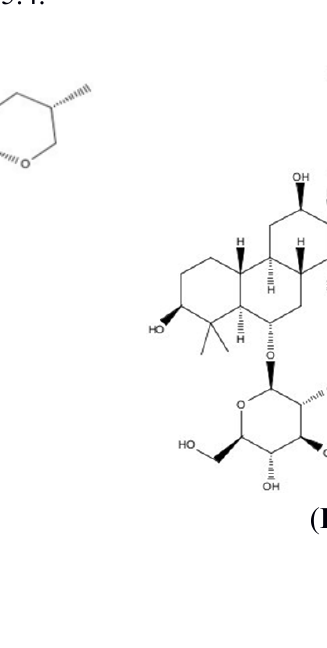
Figure 1. ( A ) Chemical structure of TA-III, TA-III MW = 740.92; and ( B ) ginsenoside Re (internal standard), ginsenoside Re MW =